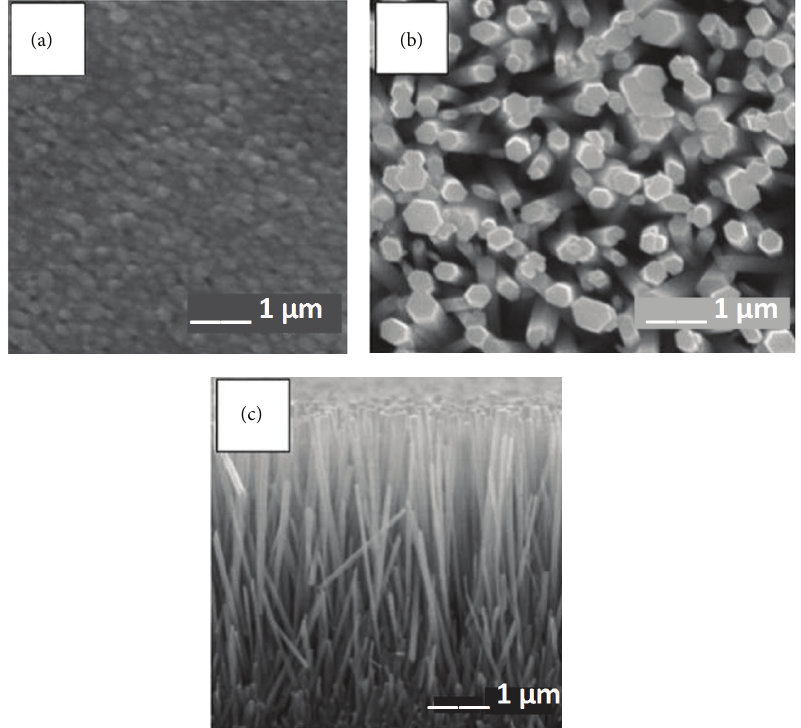
Figure 10: (a) ZnO seeds on glass substrate prepared from zinc acetate with a preheating temperature of 120 ∘ C and postannealing at 350 ∘ C for 5h. (b) Scanning electron microscopy (SEM) image of ZnO nanorods grown on substrate (a) and (c) cross-sectional view of the vertical nanorods (reproduced with the permission from